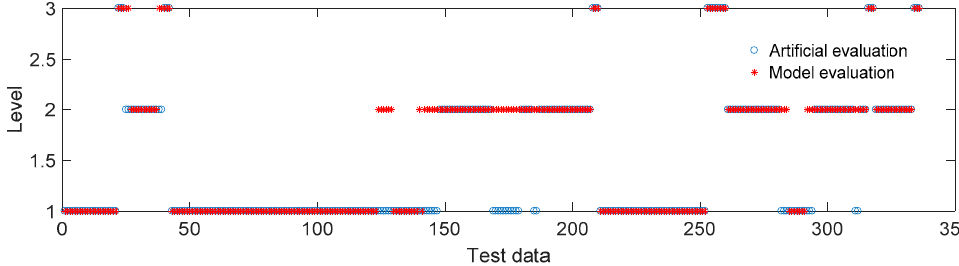
Figure 18. A comparison between the damage level classification result evaluated by the empirical approach and that predicted by the KNN-SVM model.